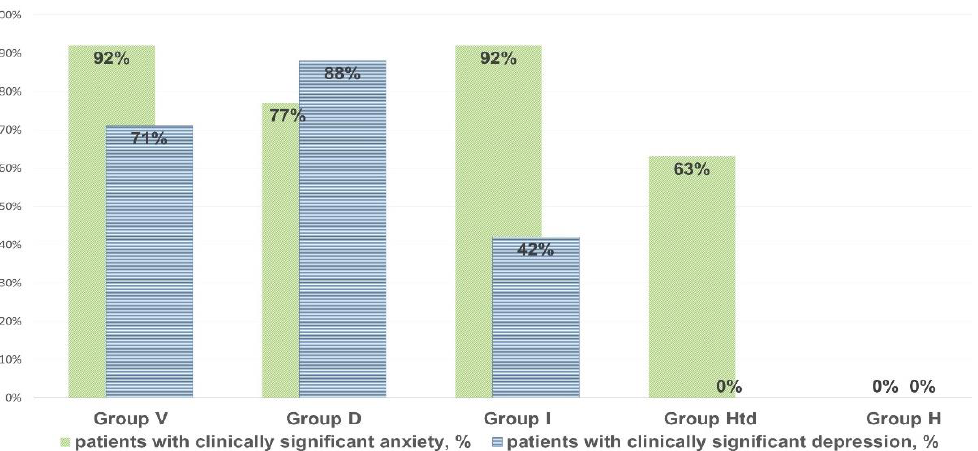
Figure 1. The prevalence of clinically significant anxiety and depression (with HADS values > 11) in chronic fatigue patients, in “healthy but tired” and in controls.